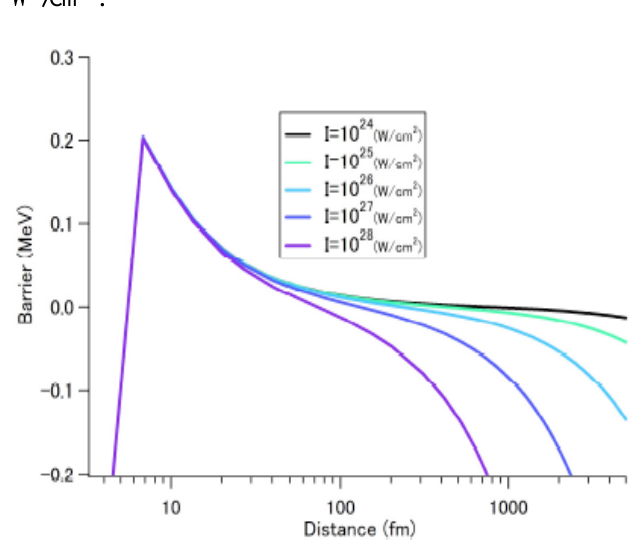
Figure 5. Nuclear potential and Coulomb barrier with various laser power intensities from 10 28 W/cm 2 to 10 24 W/cm 2 .